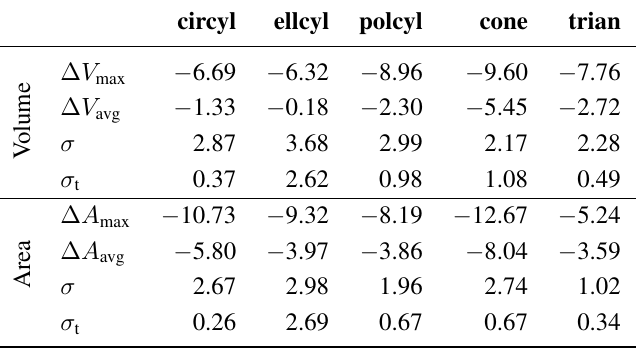
Table 5. Average and maximum volume and area errors (%) and standard deviations (pp) when second order reconstructions were compared to respective reference models.